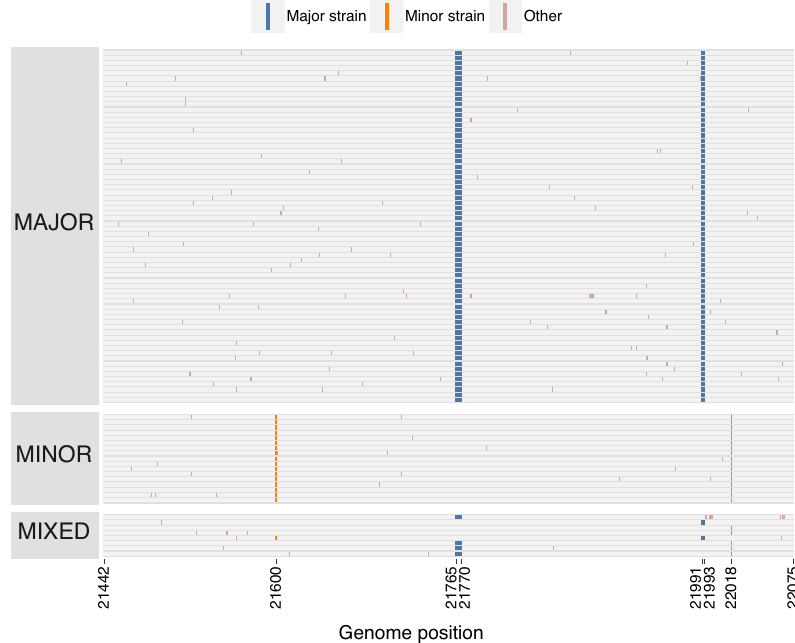
Fig. 4 Major, minor, and mixed haplotypes in the 657 nucleotide S (spike) gene cloned sequences. Each row represents a sequenced clone ( n = 93). Colored markings denote mutations from the reference genome. Major strain mutations are those found in the Alpha variant. Minor strain mutations are those found in Epsilon variant. Other mutations are found at intermediate or low